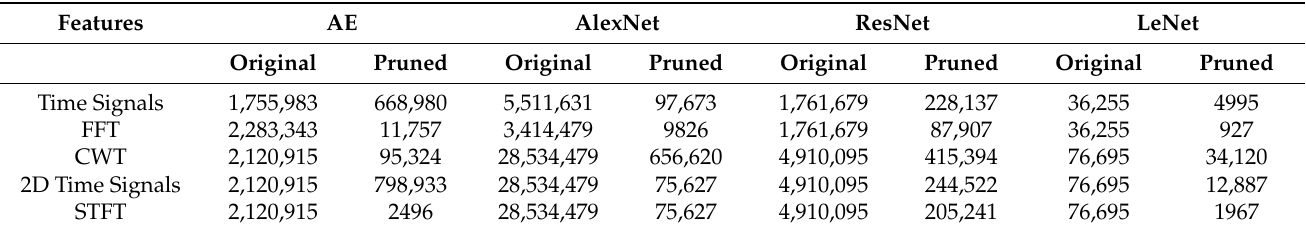
Table 5. Comparison of learnable parameters in original and pruned